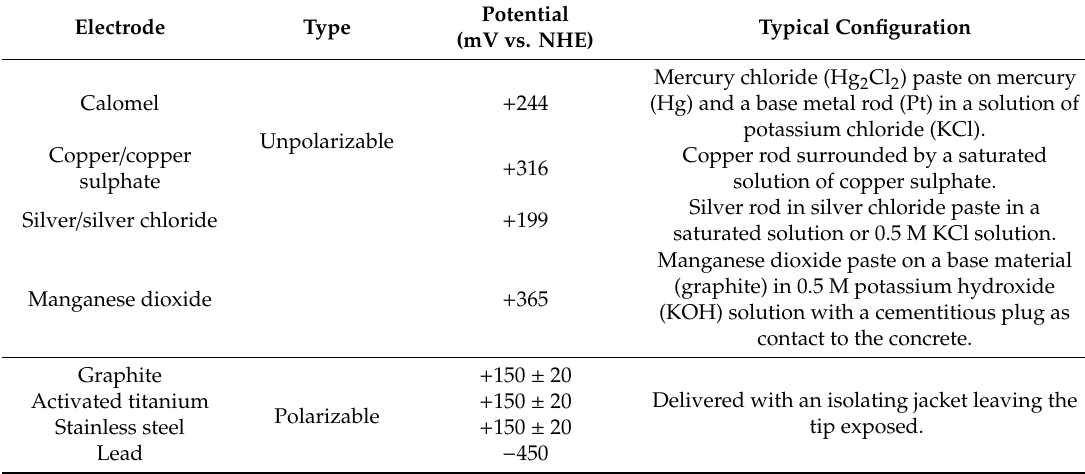
Table 2. Characteristics of commonly applied reference electrodes with their potentials versus NHE, adopted from